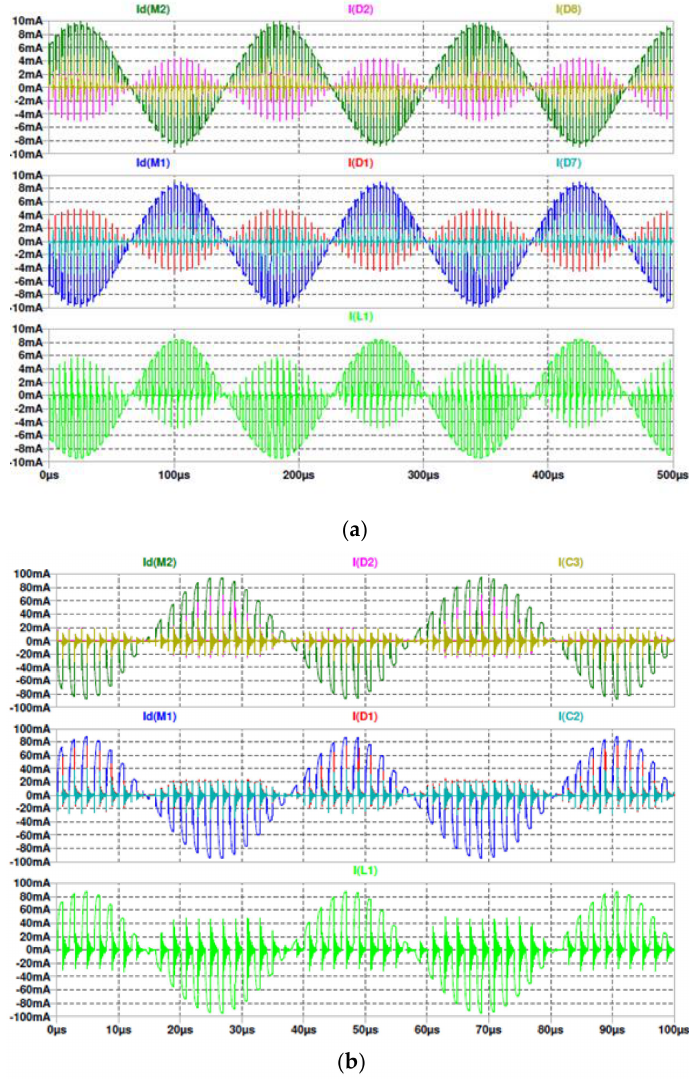
Figure 24. Circuit internal signals inside the architecture with 3 m / s wind velocity obtained with LTspice. ( a ) 3 m / s wind velocity. ( b ) 10 m / s wind